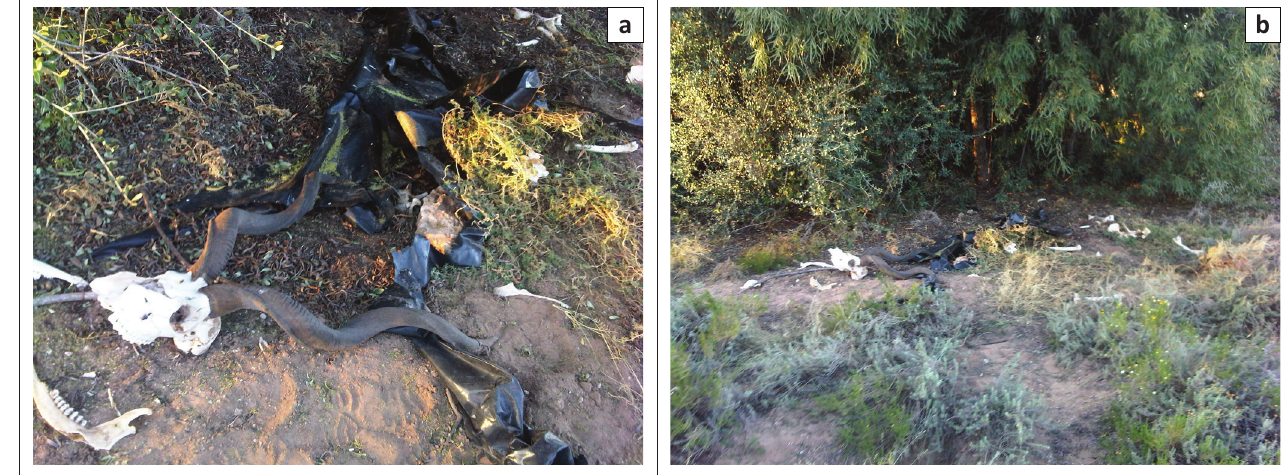
FIGURE 5: (a) Bones collected in 2012 for isolation of Bacillus anthracis from Doringbult game farm, South Africa (Table 1 samples AH56 and AH57). (b) The black plastic tarp covers and remaining kudu bones were clearly visible at this site which was sprayed with 10 % chlorine before being covered up with the plastic covers in 2008 (Table 1 sample